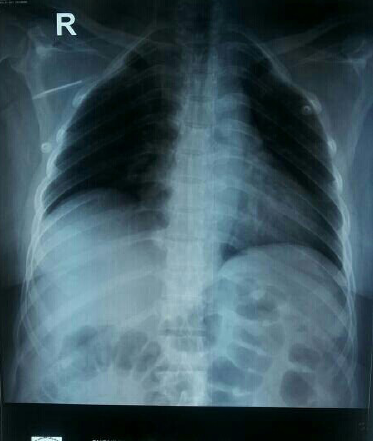
Figure 1. Postero anterior chest x-ray showing catheter’s tip in subclavian